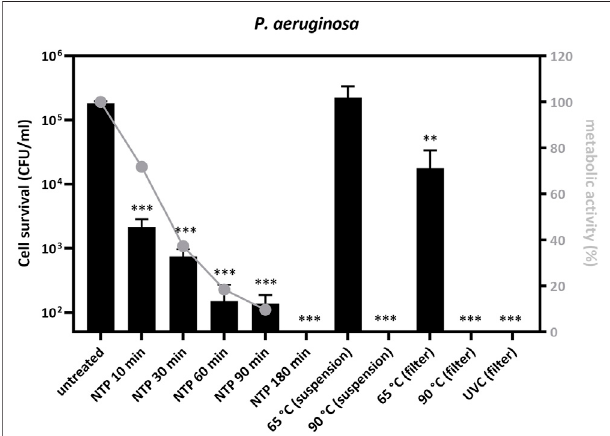
Table S1). The genome copy numbers, re fl ecting